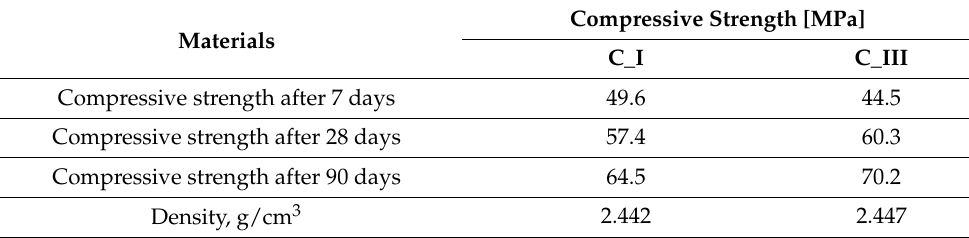
Table 6. Influence of the type of cement on the compressive strength after 7, 28 and 90 days of